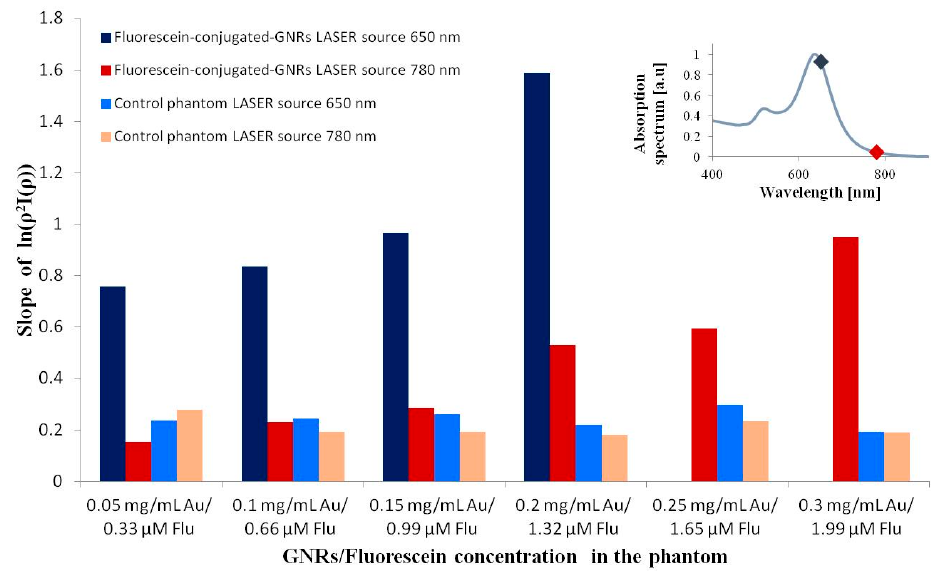
Figure 1. A bar plot of ln( ρ 2 Γ ( ρ )) slopes of the different phantoms, which were measured using the DR method. In the upper right corner, the absorption spectrum of the GNRs is presented with the DR light source wavelengths marked by diamonds.